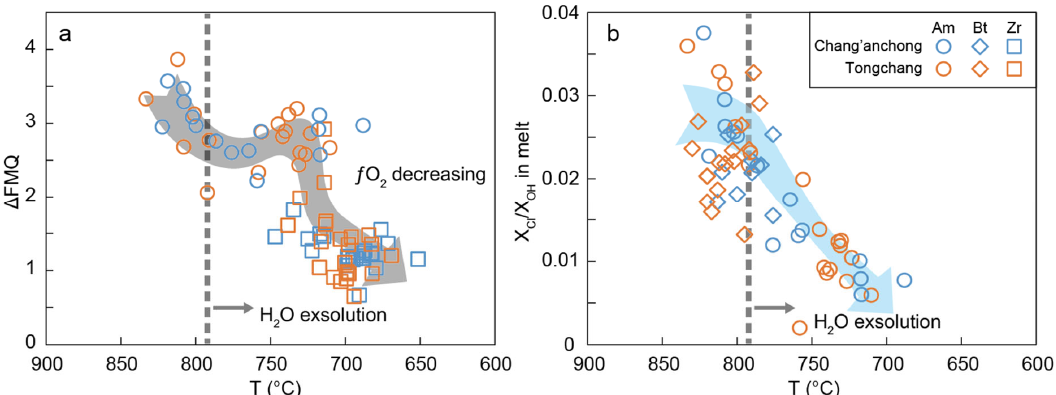
Figure 9. The calculated ( a ) ƒO 2 ( Δ FMQ) vs. T and ( b ) X Cl /X OH in melt vs. T conditions for Tongchang and Chang’anchong quartz syenite porphyries. The thick dashed line represents the H 2 O exsolution process. Am, amphibole; Bt, biotite; Zr, zircon.